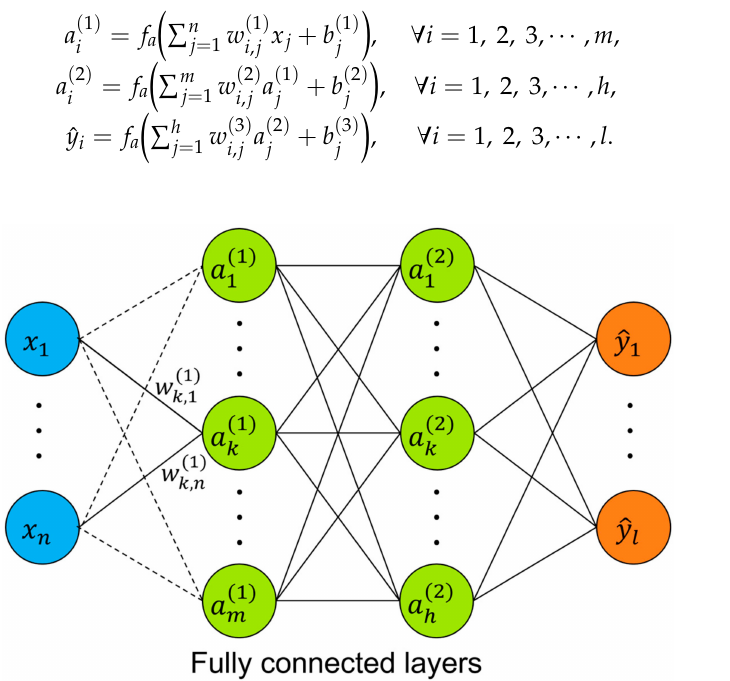
Figure 1. DNN structure to establish the empirical relationship between the input and the output layer.